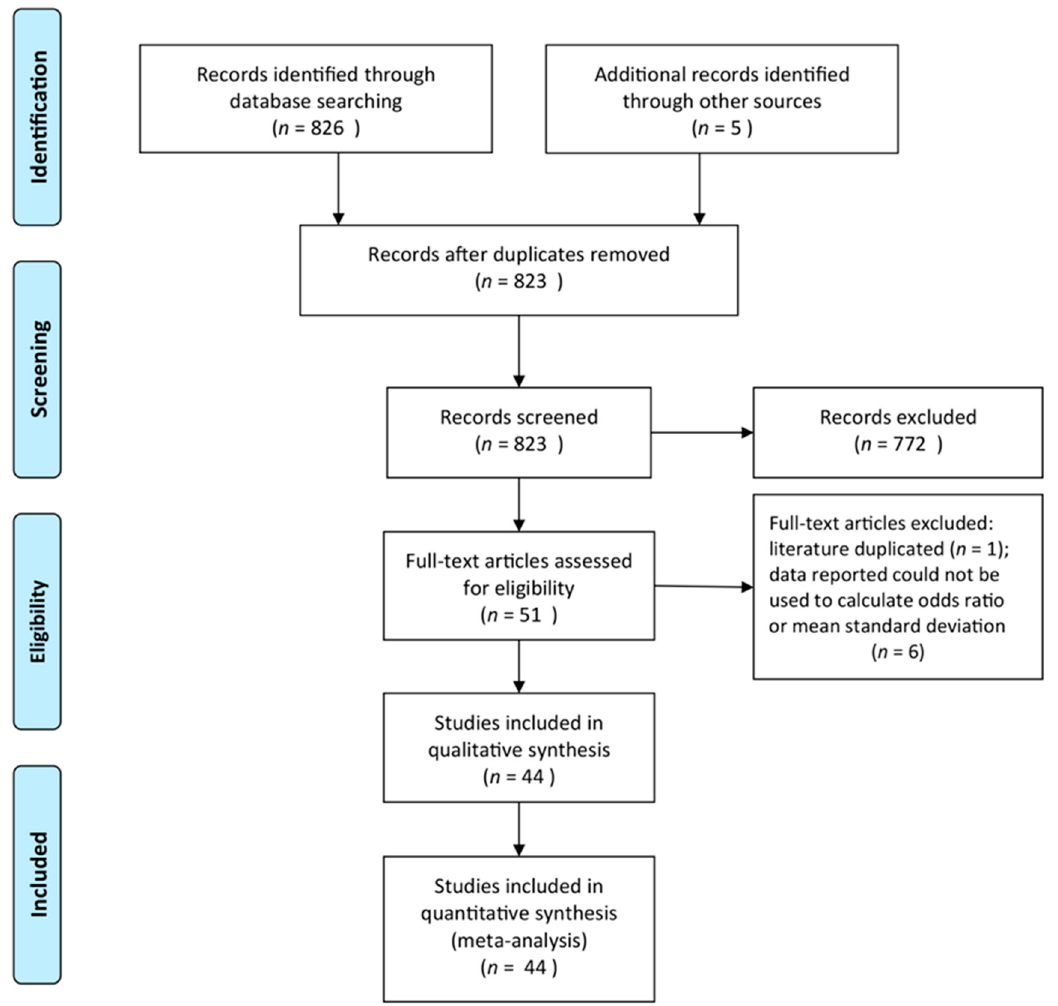
Figure 1. A flow chart of the literature selection process [68].